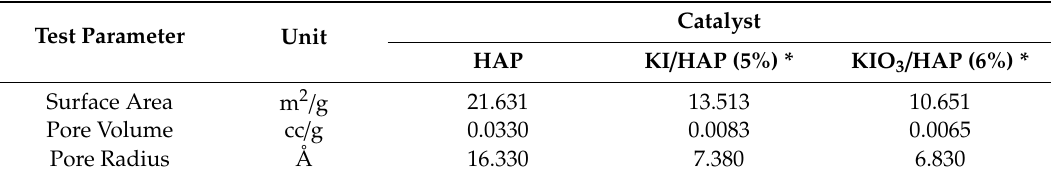
Table 1. BET analysis result.